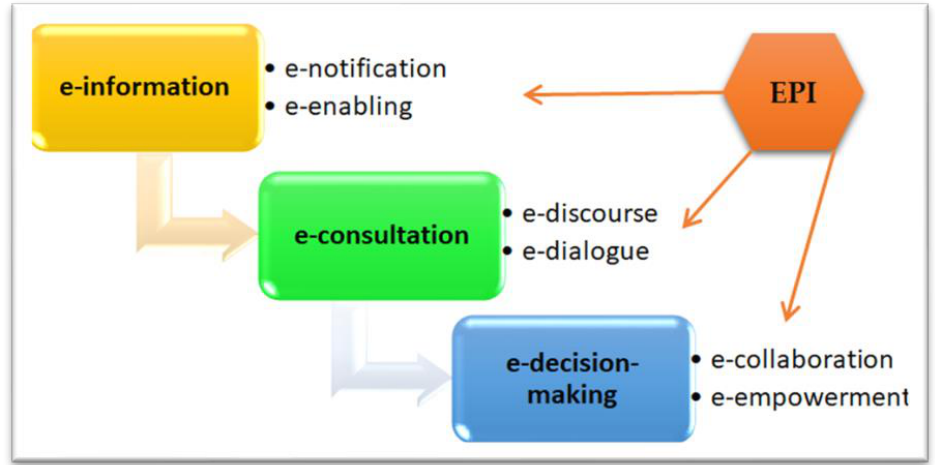
Figure 2. E-participation index (EPI) dimensions.